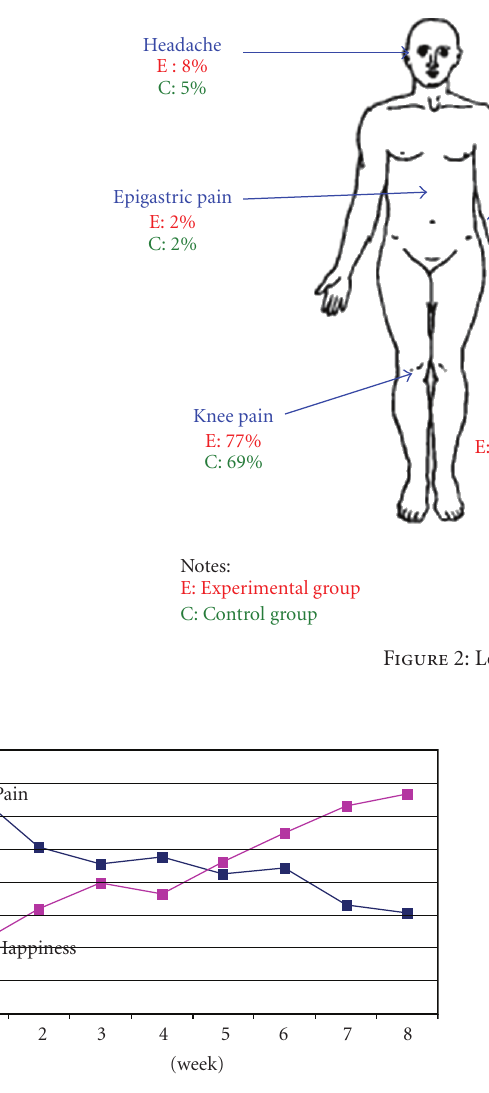
Figure 3: Pain and happiness scores over the 8-week humor therapy program. # The Friedman Test was used. ∗ A P -value of (cid:2) .05 was considered statistically